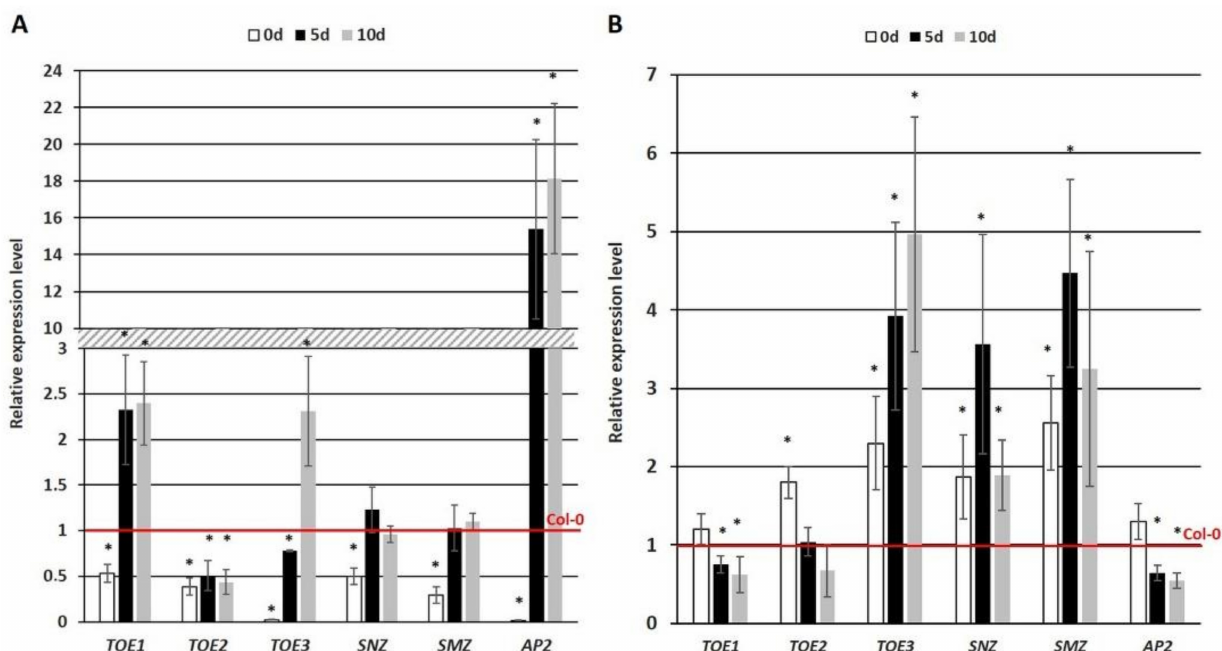
Figure 4. Expression analysis of the candidate miR172 target genes ( TOE1 , TOE2 , TOE3, SNZ , SMZ , AP2 ) in the embryogenic cultures of the 35S::MIM172 ( A ) and 35S:: MIR172D ( B ) lines with a disrupted miR172 function and an increased miR172 level, respectively. The relative transcript level was normalized to an internal control ( At4g27090 ) and calibrated to the WT (Col-0) culture of the same age (0d, 5d and 10d). * values significantly different from the Col-0 culture of the same age ( p < 0.05; n = 3 ±